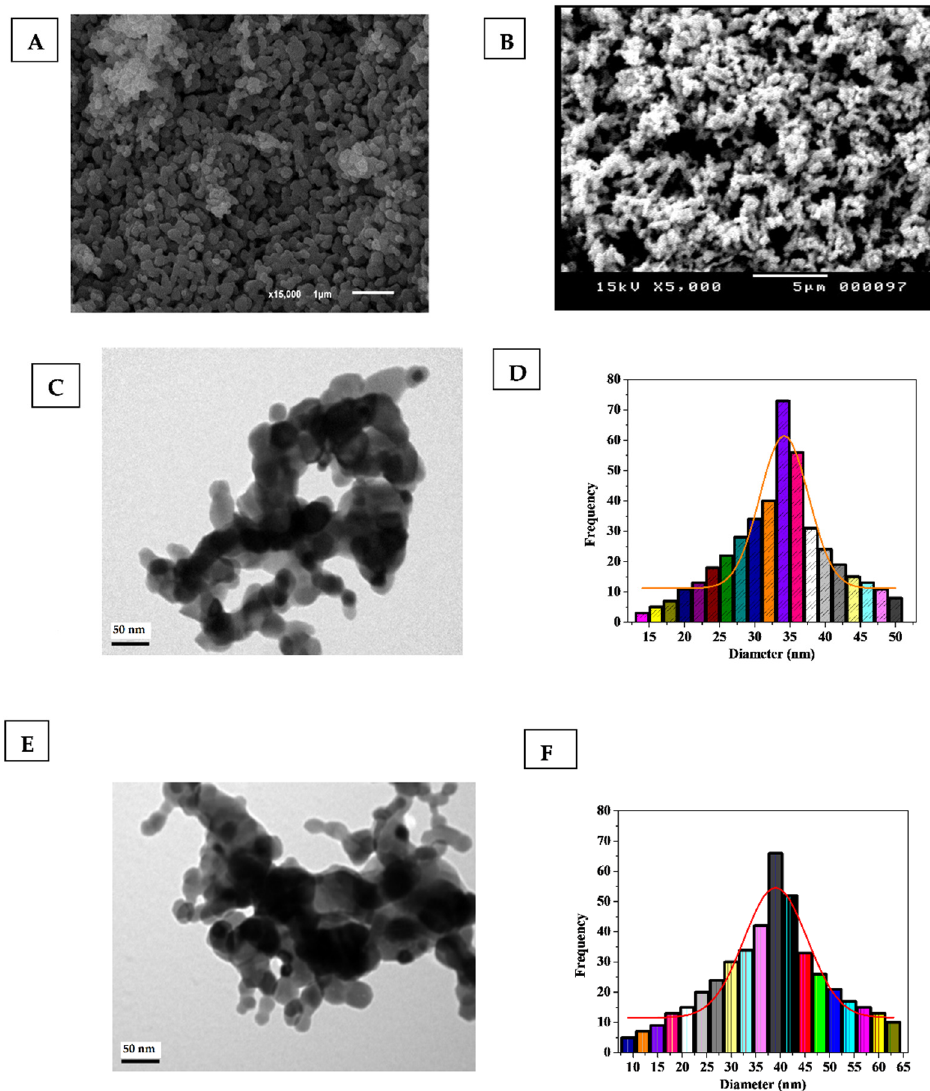
Figure 2. SEM image of ( A ) ZnONPs and ( B ) AZM-ZnONPs; TEM images of ( C ) ZnONPs and ( E ) AZM-ZnONPs and their particle size distribution in ( D , F ), respectively.